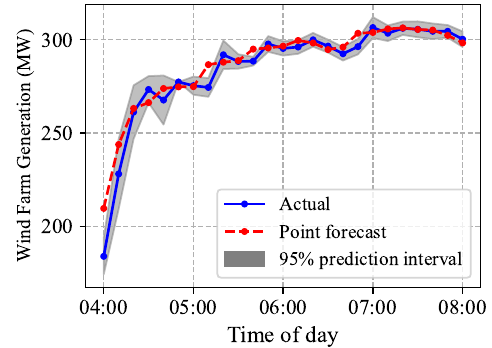
Figure 10. On 5 January 2010.